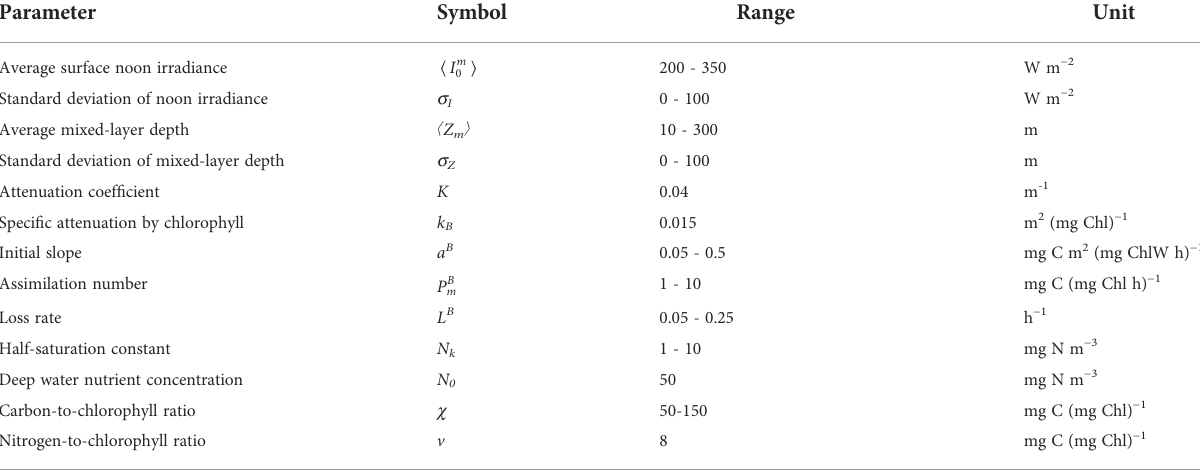
TABLE 1 Parameters and their typical values used in